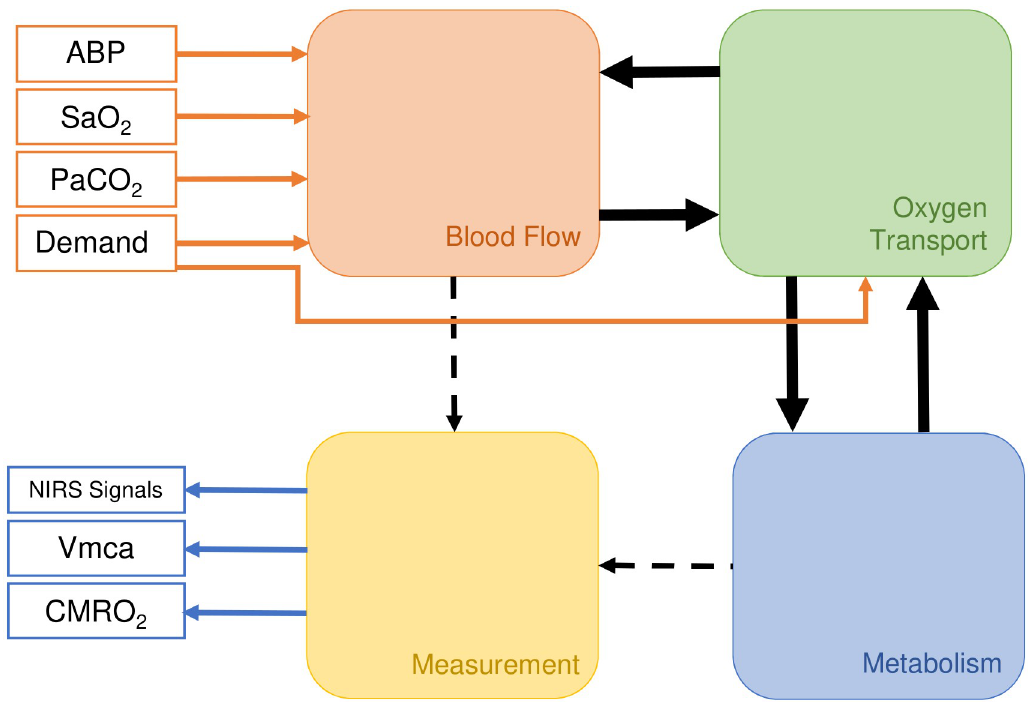
Fig 2. Simplified structure of a typical BrainSignals model. A typical BrainSignals model can be split into four compartments or submodels. The blood flow submodel represents blood flow from arteries to veins via the capillary bed and the oxygen transport submodel estimates diffusion of dissolved O 2 from the capillary blood to the brain tissue. Delivered oxygen is then utilised by the metabolism submodel. Finally, the measurement submodel translates the internal states of the blood flow and metabolism submodels into observable outputs. Model inputs are shown in red and consist of arterial blood pressure (ABP), arterial oxygen saturation (SaO2), partial pressure of CO 2 (PaCO2) and a parameter specifying relative demand, whilst measurable outputs are shown in blue, including NIRS signals as well as middle cerebral artery velocity (Vmca) and cerebral metabolic rate of oxygen (CMRO 2